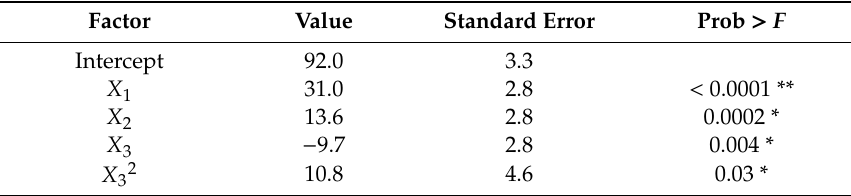
Table 4. The estimated parameters for variables with significance.